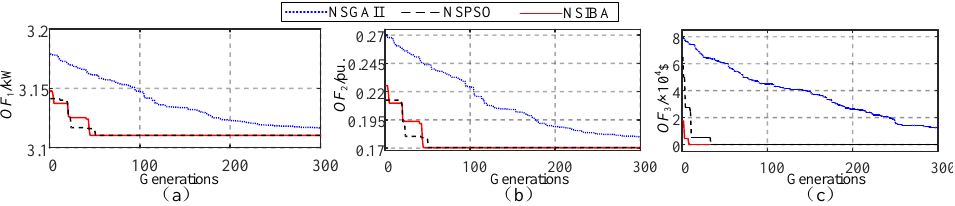
Figure 6. The convergence property for OFs of NSIBA and other methods; ( a ) minimum network power loss, ( b ) minimum voltage stability margin, and ( c ) total cost of investment and operation.